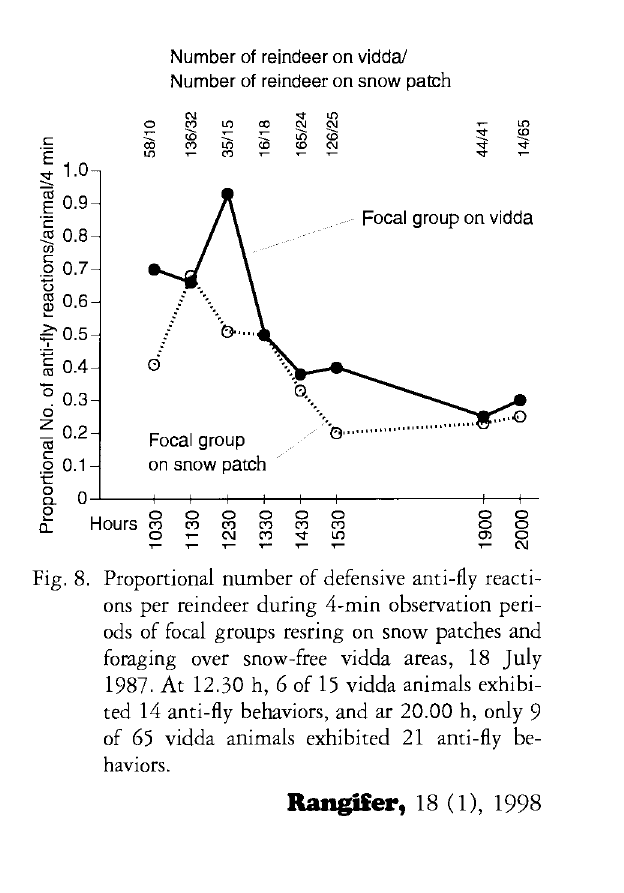
Fig. 8. Proportional number of defensive anti-fly reacti ons per reindeer during 4-min observation peri ods of focal groups resring on snow patches and foraging over snow-free vidda areas, 18 July 1987. At 12.30 h, 6 of 15 vidda animals exhibi ted 14 anti-fly behaviors, and ar 20.00 h, only 9 of 65 vidda animals exhibited 21 anti-fly be